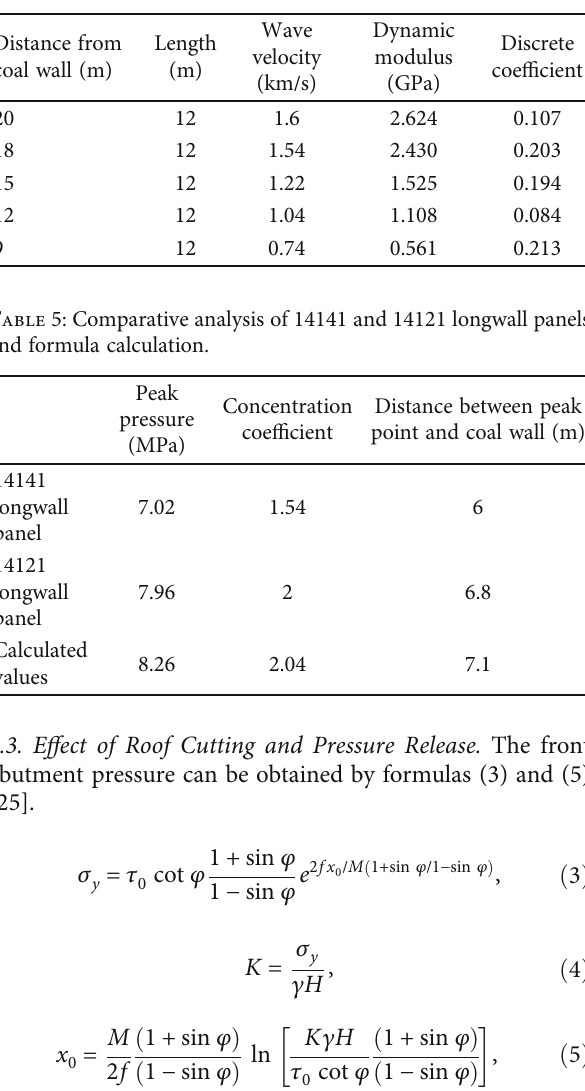
Table 4: Monitoring results of the ultrasonic logging with “ one transmitter and two receivers ” .